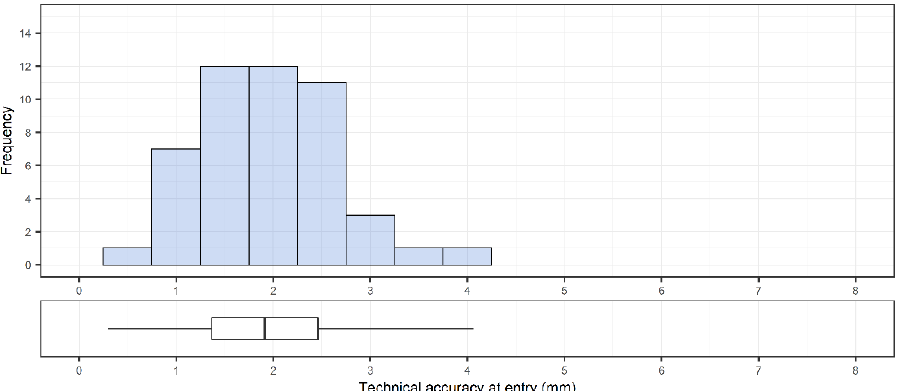
Figure 4. Overall distribution of technical accuracy of placed pedicle screws (n = 48) at bone entry point. Corresponding box plot with median and interquartile range are included below the histogram.